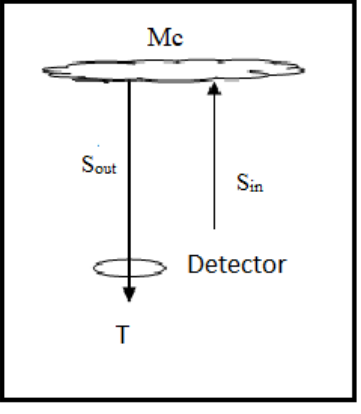
Fig.1 Stokes vectors S